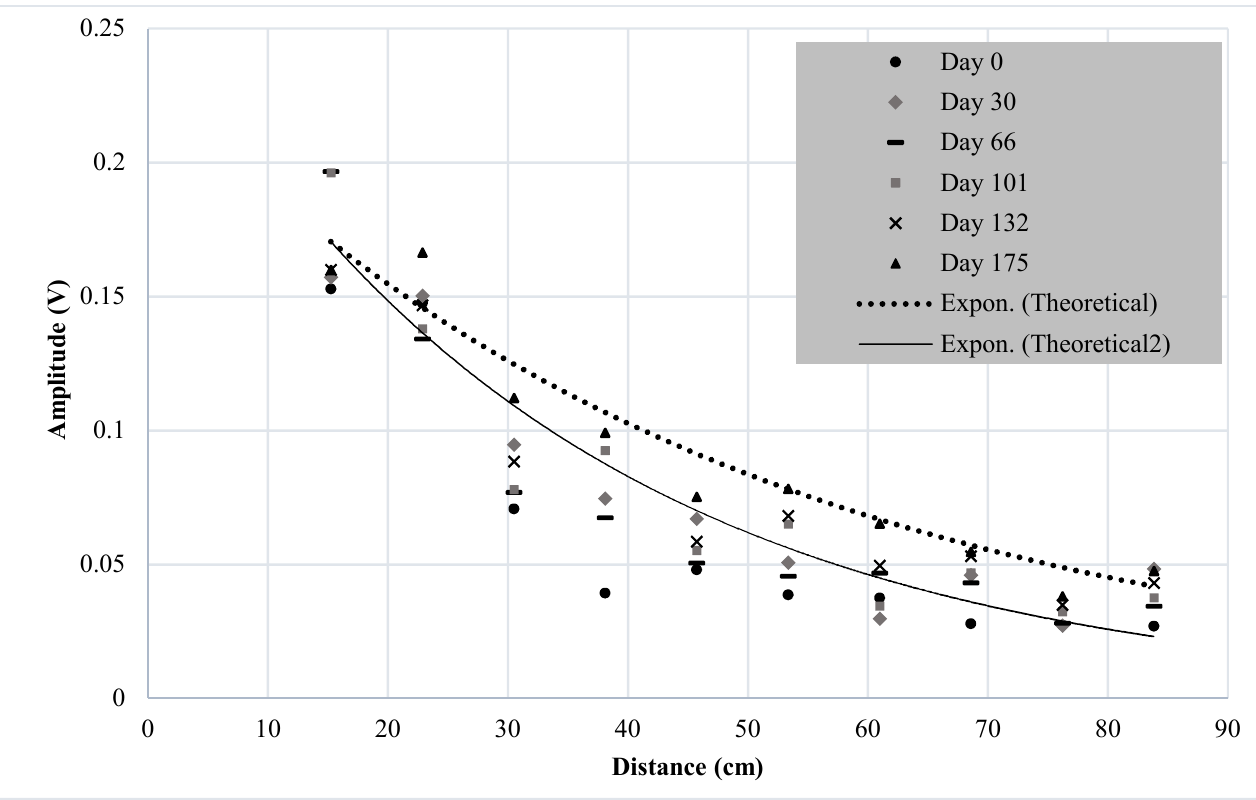
Figure 6. Comparison of select data through 175 days, Specimen A.